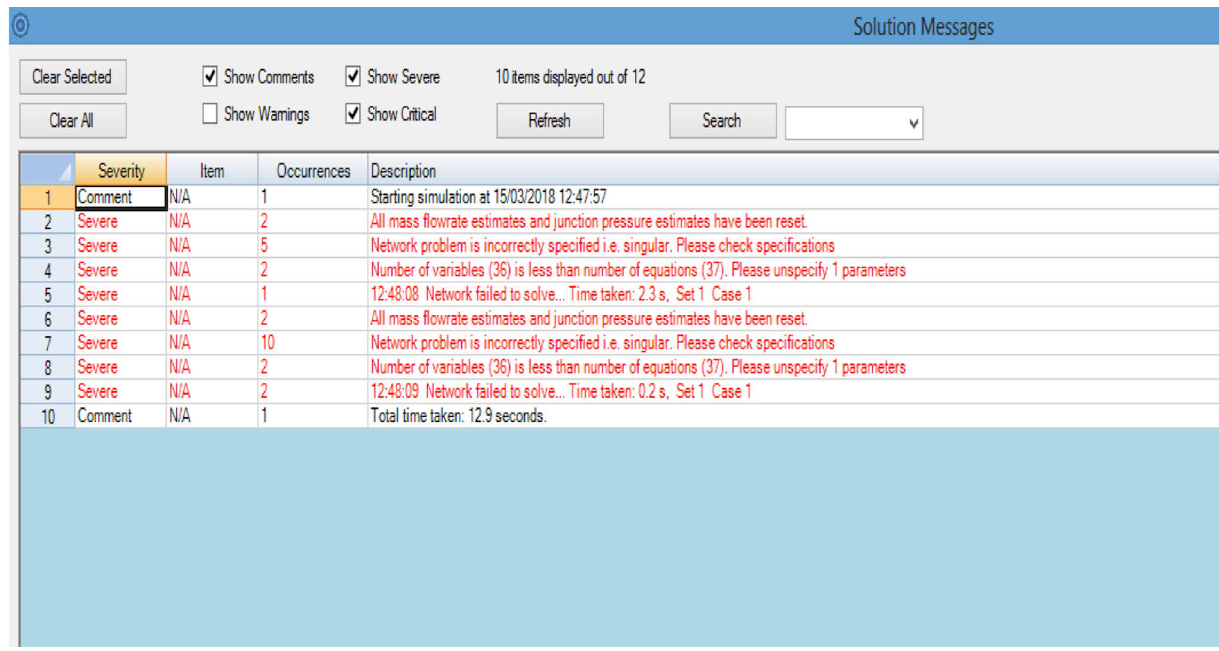
Fig. 13 Simulation run error messages for LDHI at 10 gal/h